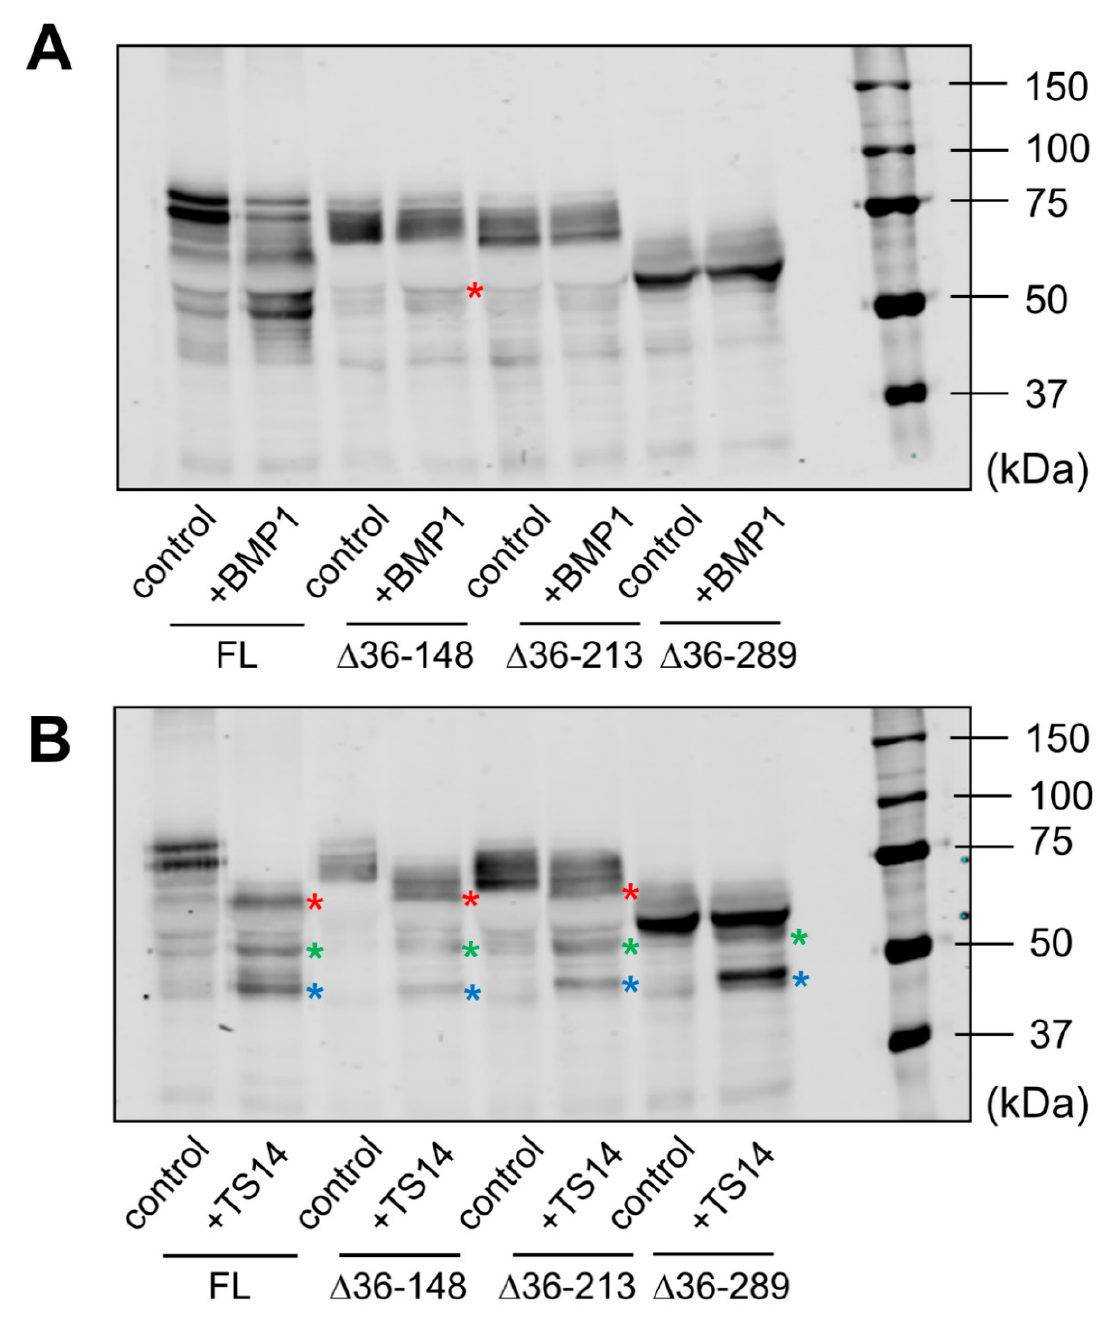
Figure 5. Analysis of BMP1- and ADAMTS14-mediated proteolysis in LOXL1 truncated forms. Secreted forms of full-length (FL) and truncated LOXL1-GFP proteins were exposed to BMP1 ( A ) or ADAMTS14 ( B ) for 2 h at 37 °C and analyzed by Western blotting using the anti-GFP antibody. Note that BMP1 cleaved the ∆ 36–148 form, though less efficiently compared to the full-length form (red asterisk in panel A indicates the proteolytic product). The remaining forms were apparently not cleaved by BMP1. Digestion with ADAMTS14 revealed a set of proteolytic products labelled with red, green, and blue asterisks in panel B. Lack of red-labeled product in the ∆ 36–289 construct confirmed the ADAMTS14 cleavage site at the 216–217 position. The blots shown correspond to representative experiments performed twice with two independent preparations.